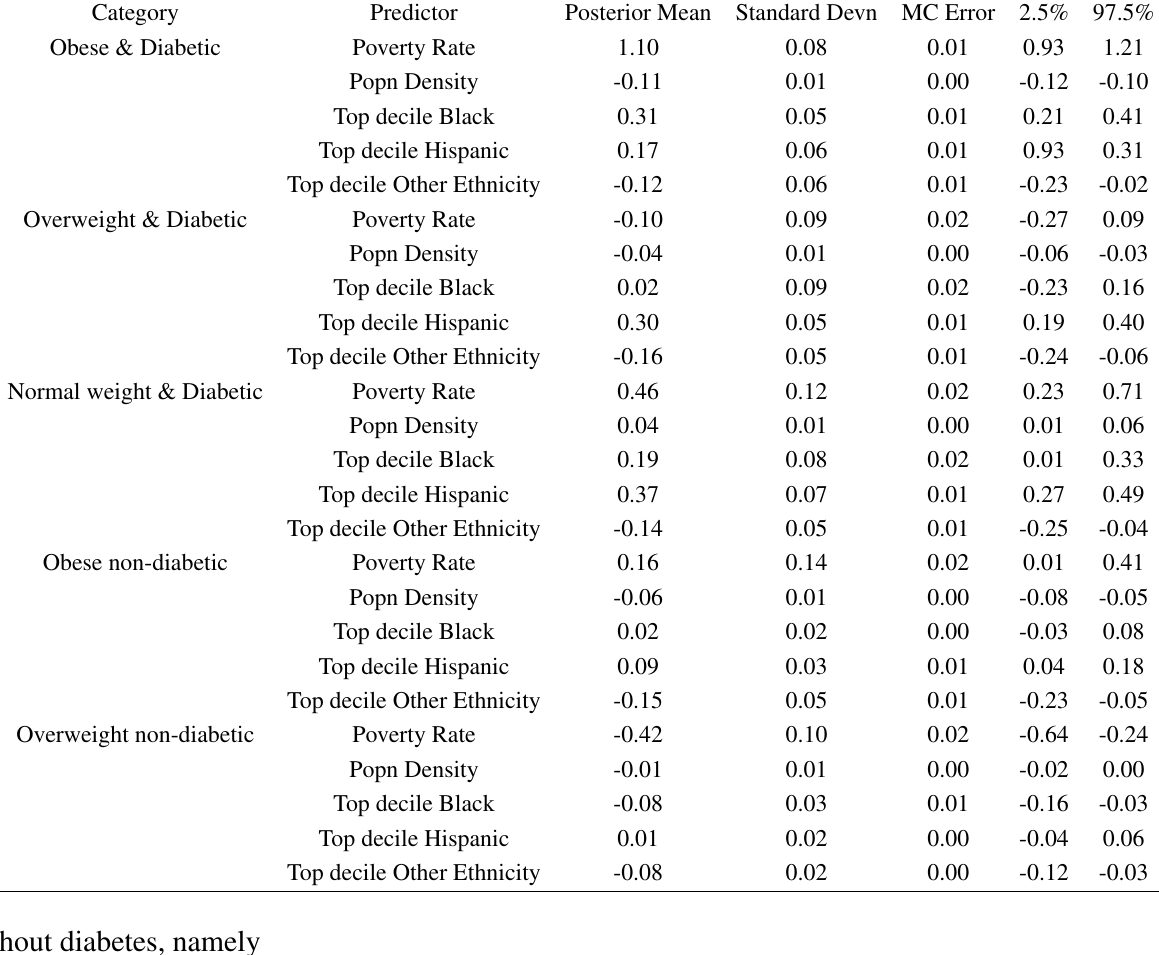
Table 6 . Effects of county predictors by diabetes-weight category, model 2.